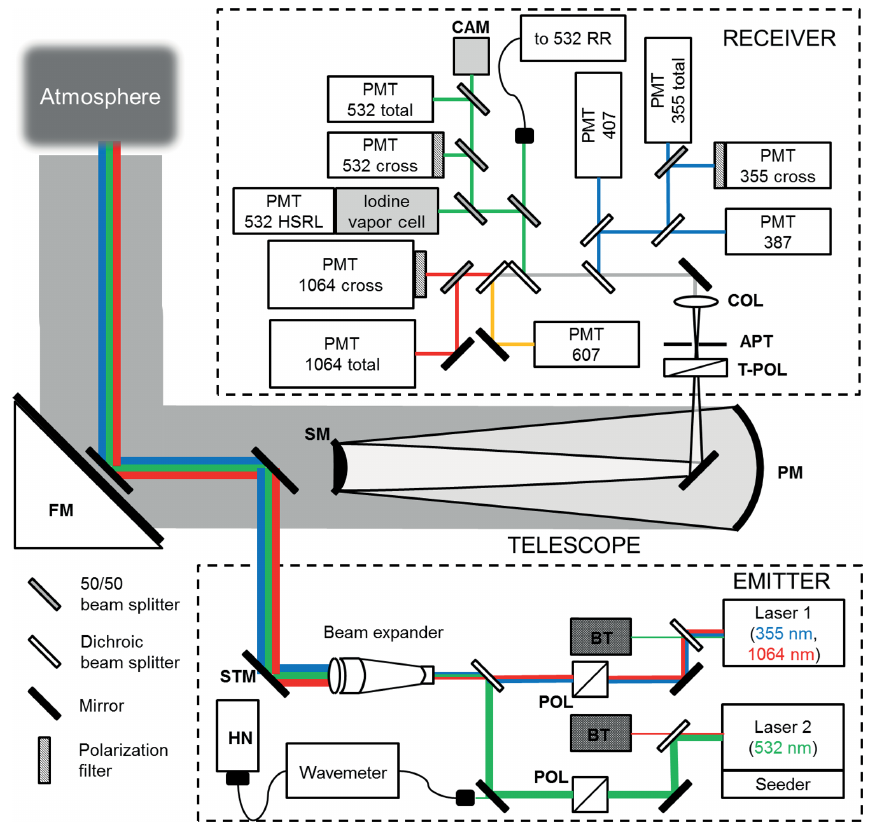
Figure 1. Sketch of BERTHA’s emitter and receiver. All detection channels are photomultiplier tubes (PMTs, operated in the photon counting mode) and the numbers indicate the central wavelength of transmission in nanometers of the interference filter. Polarization filters are oriented perpendicular to the emitted state of polarization and are placed in front of the “cross” channels. The “total” channels measure the cross and the parallel part of the backscattered light. POL denotes polarizer to purify the laser polarization, BT denotes beam trap, HN denotes helium neon laser as reference for the wavemeter, STM denotes steering mirror with stepper motors to adjust the overlap, CAM denotes camera to visualize the overlap, FM denotes flat mirror (consisting of two mirrors, the small one for emitted pulses, the large one for backscattered light), PM stands for main or primary mirror and SM for counter or secondary mirror of the Cassegrain telescope, and TPOL means turnable polarization filter for (cid:49) 90 ◦ calibration, APT motorized aperture, and COL collimator. Finally RR denotes rotational Raman channel, and HSRL denotes the high-spectral-resolution lidar